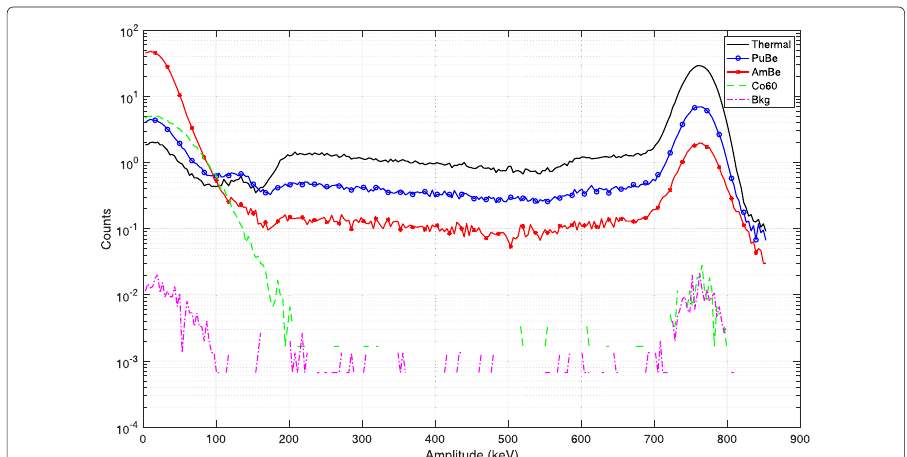
Fig. 10 Pulse Height Spectrum (PHS) normalized over time for different sources: Am/Be and Pu/Be for the